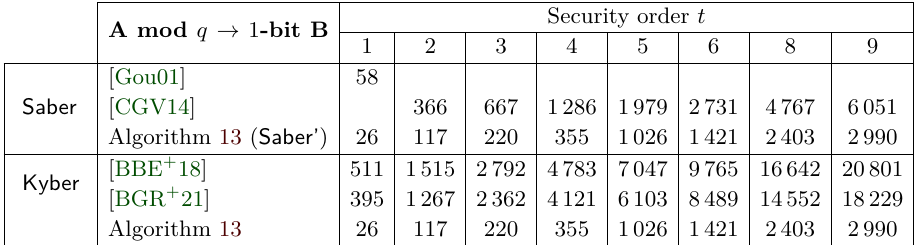
Table 11: Operation count for arithmetic modulo q to 1-bit Boolean conversion algorithms, up to security order t = 10, with n = t + 1 shares, for Kyber and Saber , with q = 3329 for Kyber and q = 2 10 for Saber . For Algorithm 13, we use the values of ‘ from Table 8 corresponding to ∆ = 0 .